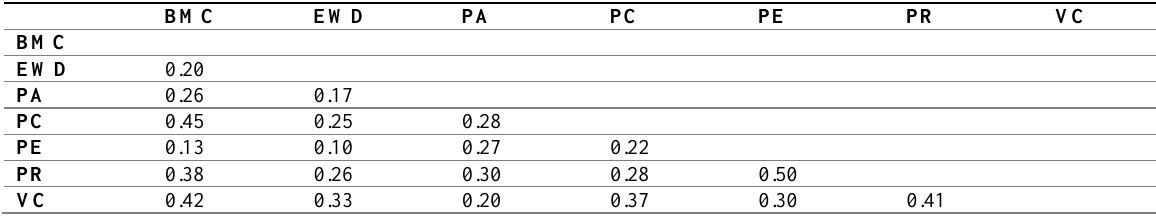
Table 4 : Heterotrait-Monotrait ratio